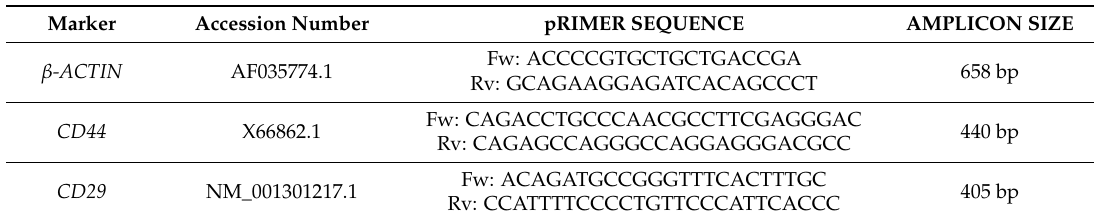
Table 4. Gene name, accession number, primer sequences and amplicon size of genes used for expression analysis of